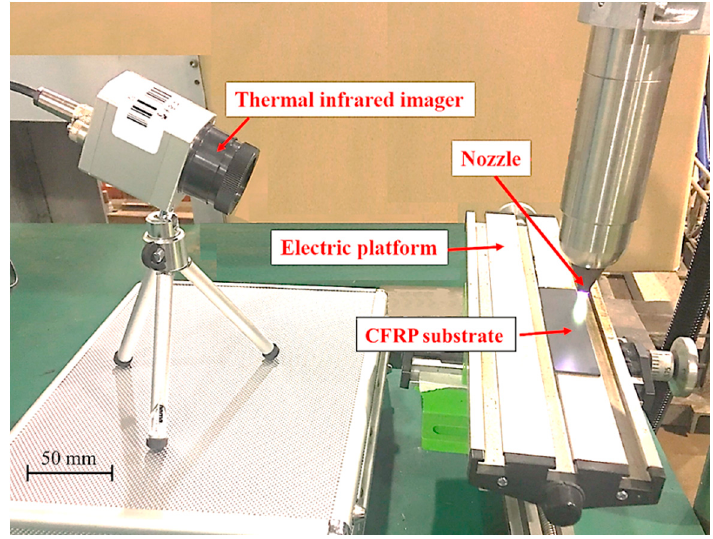
Figure 4. Measuring the surface temperature of a CFRP substrate during atmospheric pressure plasma treatment (APPT).